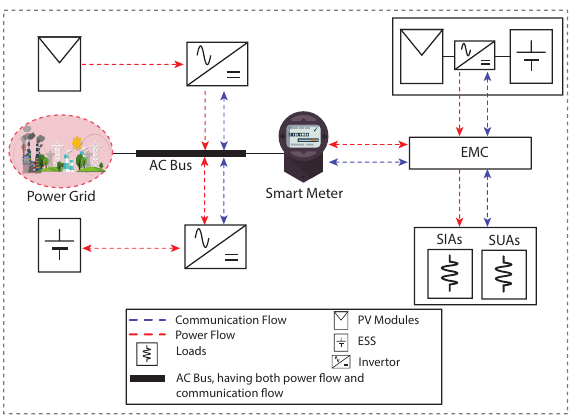
Figure 1. Proposed system model for optimal energy management in smart